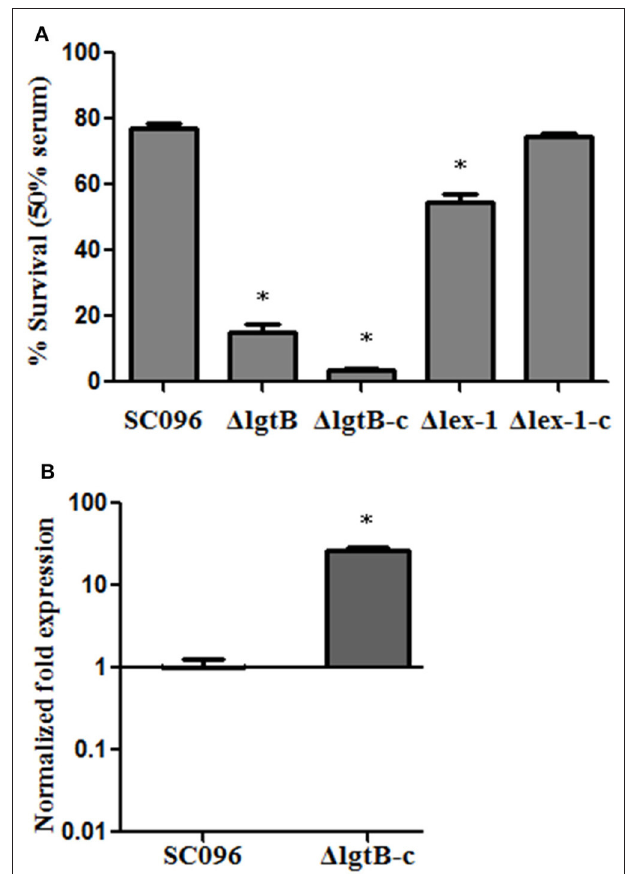
FIGURE 4 | Survival of H. parasuis strains in 50% porcine sera (A). The survival percentage was calculated as the ratio of colonies in fresh serum to those in heat-treated serum. Error bars represent the standard deviation from three independent experiments. The asterisks indicate that the survival of bacteria in serum was statistically different ( p < 0.01) from that of the wild-type SC096 strain as judged by the Student t- test. qRT-PCR analysis of mRNA levels of lgtB in 1 lgtB -c mutant compared with mRNA levels wild-type SC096 (B) . The data represent means standard errors ( n = 3). The asterisks indicate that mRNA levels of lgtB in the complemented strain was statistically different ( p < 0.01) from that of the wild-type strain as judged by the Student t-